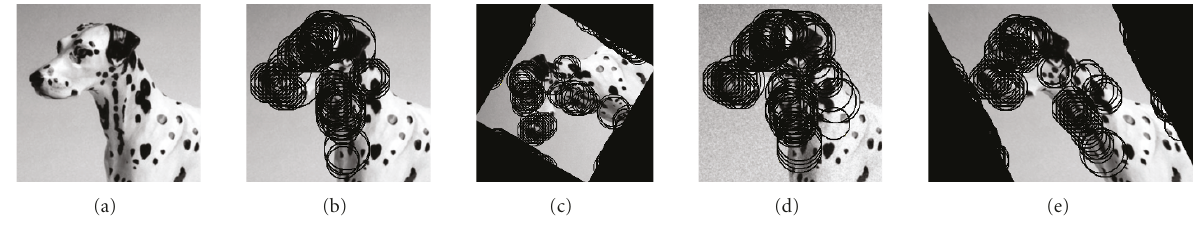
Figure 6: Image transformation tests for CSR responses: (a) input image, (b) initial CSR region detection, (c) 60 degree rotation, (d) white noise, and (e) a ffi ne transformation.